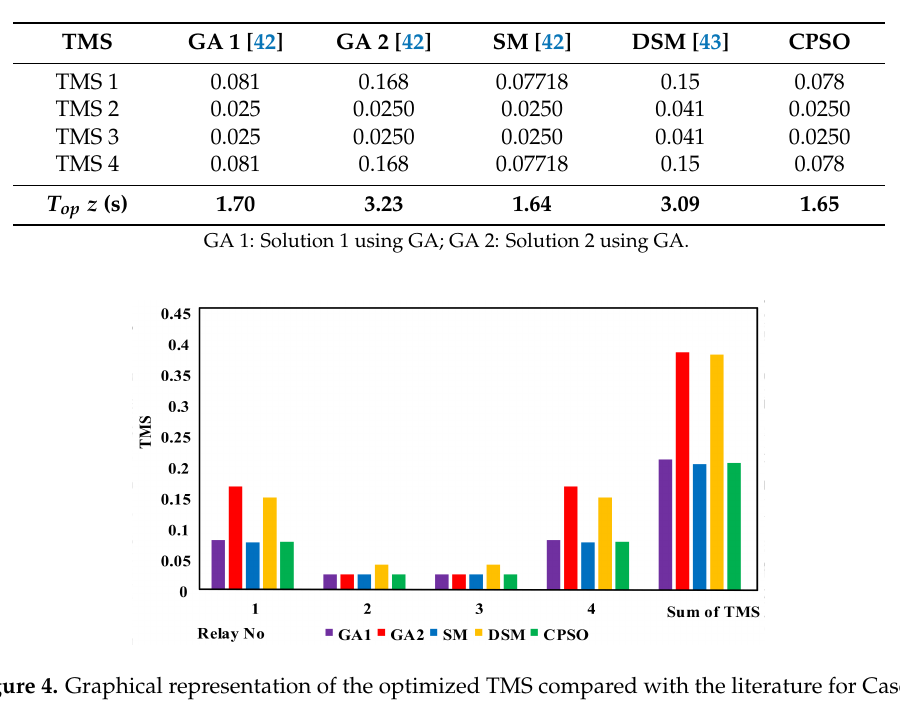
Table 3. Comparison of the optimized TMS by the proposed method with the literature for Case I.